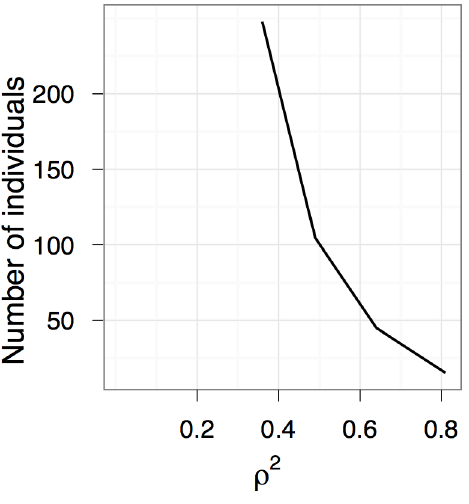
Figure 3. Number of individuals needed to detect positive growth autocorrelation. The line represents the minimum number of individuals in a cohort needed to statistically detect that r 2 is greater than 0 at least 80 percent of the time, based on the 95% confidence =16 and n t =16 (see Simulating intervals of 1000 simulations with s 2 g growth data section for details). When r 2 , 0.36, more than 512 individuals are needed, beyond the simulated range.